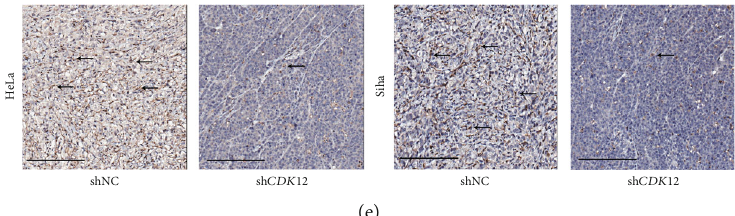
Figure 5: High-expression of CDK12 enhances the macrophages in fi ltration. (a) Heatmap of the di ff erent genes by shRNA-mediated CDK12 knockdown. (b) Volcano plotting of the di ff erent genes by shRNA-mediated CDK12 knockdown. (c) Gene set enrichment analysis (GSEA) using hallmark gene sets by shRNA-mediated CDK12 knockdown. (d) The abundances of seven in fl ammatory/immune in fi ltrates (B cells, CD4+T cells, CD8+T cells, neutrophils, macrophages, monocyte, and dendritic cells) are estimated by the TIMER algorithm. (e) Typical IHC images of F480 from xenograft under HeLa and Siha cells treatment with sh-NC and sh CDK12 -1. Scale bar: 200 μ